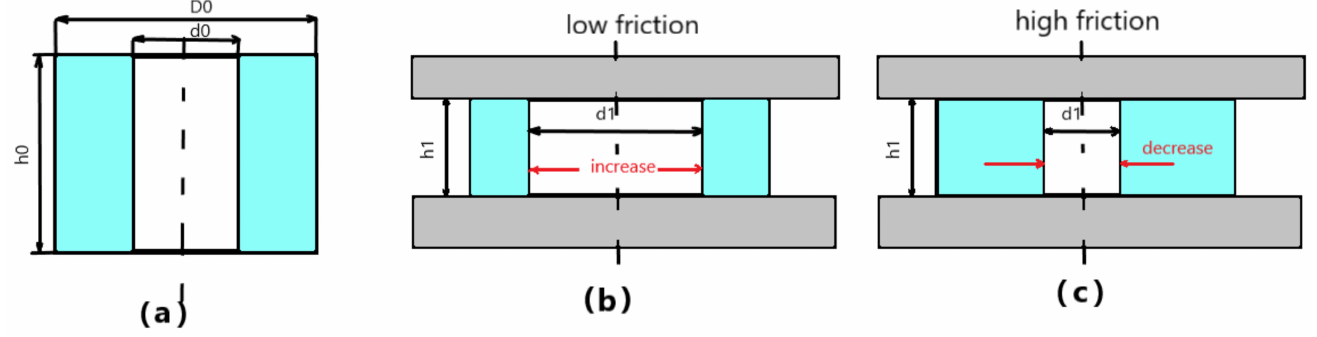
Figure 4. Material flow in ring compression: ( a ) initial state ( b ) low friction condition and ( c ) high friction